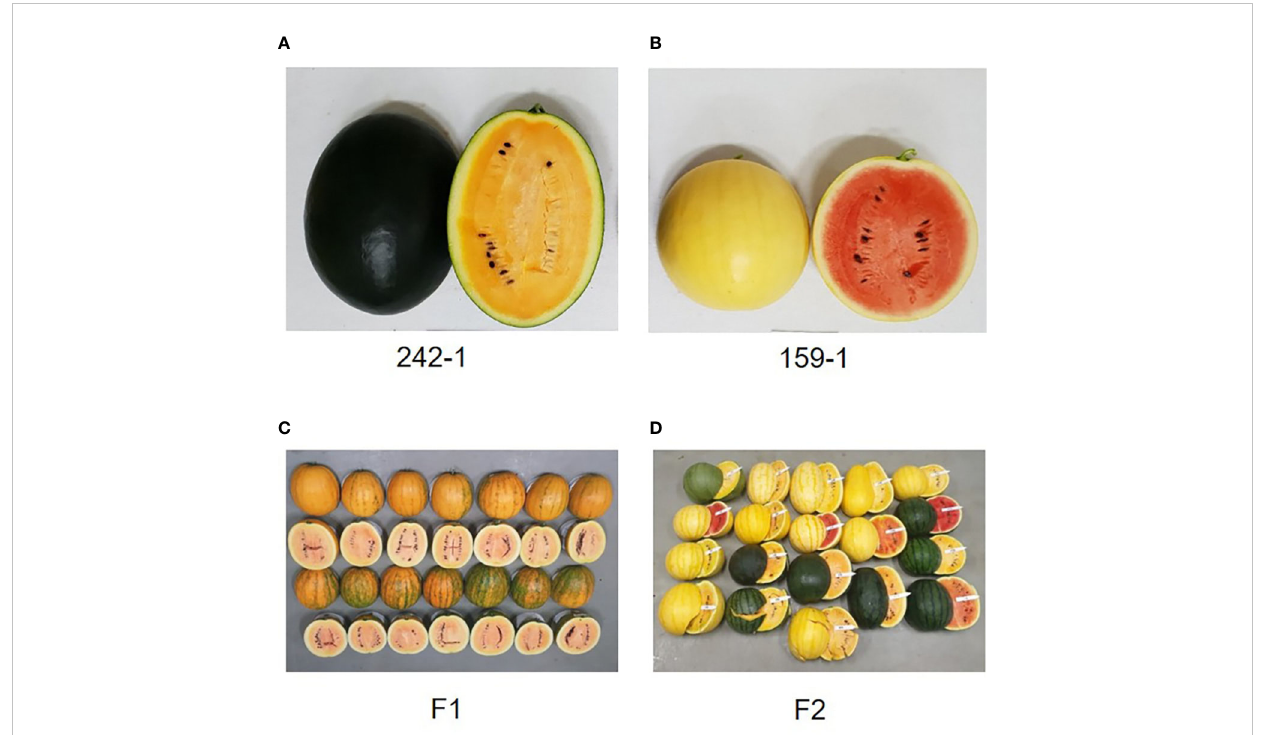
FIGURE 1 Morphological characteristics of the inbred parental lines and F 1 and F 2 individuals. (A, B) Fruits of parental cultivars 242-1 (A) and 159-1 (B) . (C) Fruits of F 1 hybrids are round with striped rind and yellow fl esh color. (D) Fruits of F 2 individuals produced by self-pollination of F 1 individuals. The F 2 generation segregated into various rind colors (dark green, black, and mixture of black and dark green) and fl esh colors (red, orange, and mixture of red and